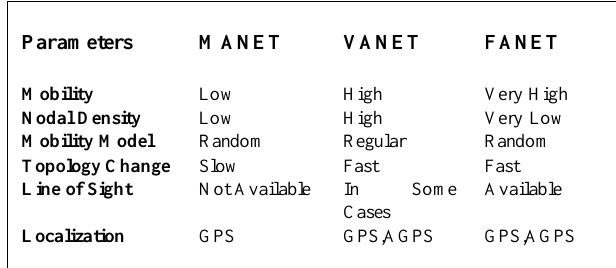
Table 1. Comparison different types of